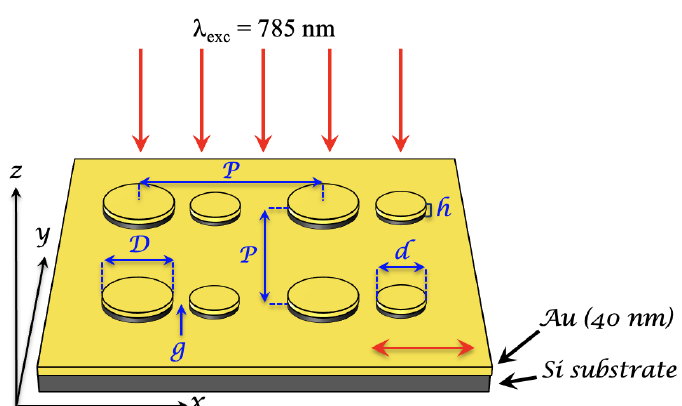
Figure 1. Design scheme of the Au/Si asymmetric dimer array on gold film (thickness = 40 nm) with all the paramaters of nanodimers: D = 130 nm, d = 65 nm, P = 300 nm, g = 10 nm and h = 40 nm (Si+Au). The red arrows correspond to the illumination by a laser at 785 nm under normal incidence, and at the bottom right, the double red arrow corresponds to the polarization direction of the laser oriented along the dimer